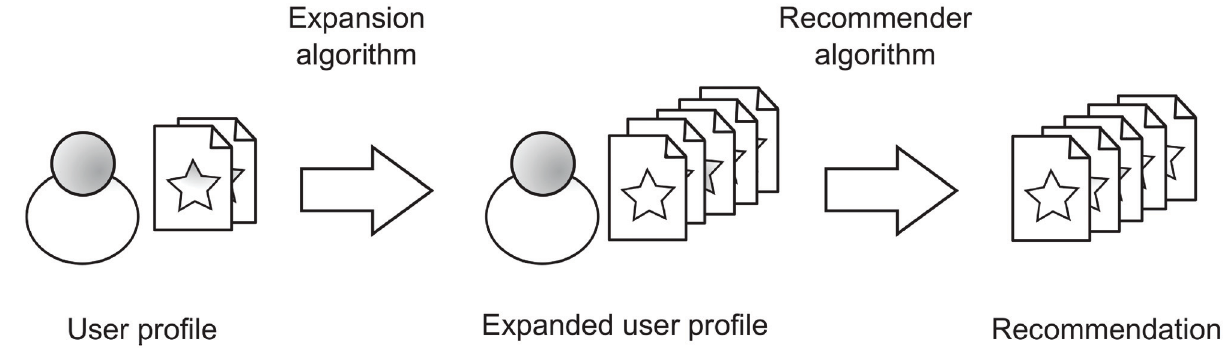
Fig 1. Recommendation process using Profile